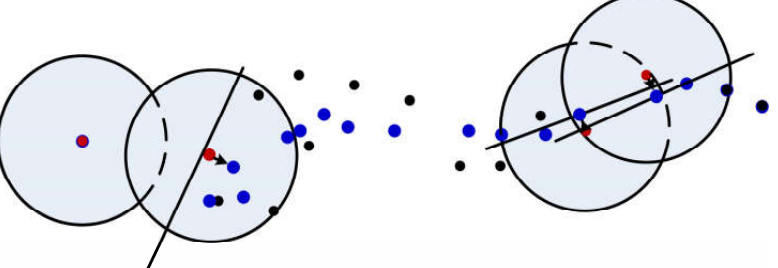
Figure 13. Diagram of the normalized smoothing process of the local straight line of the potential discontinuity trace points (the black points and red points are the points before smoothing, and the blue points are the points after